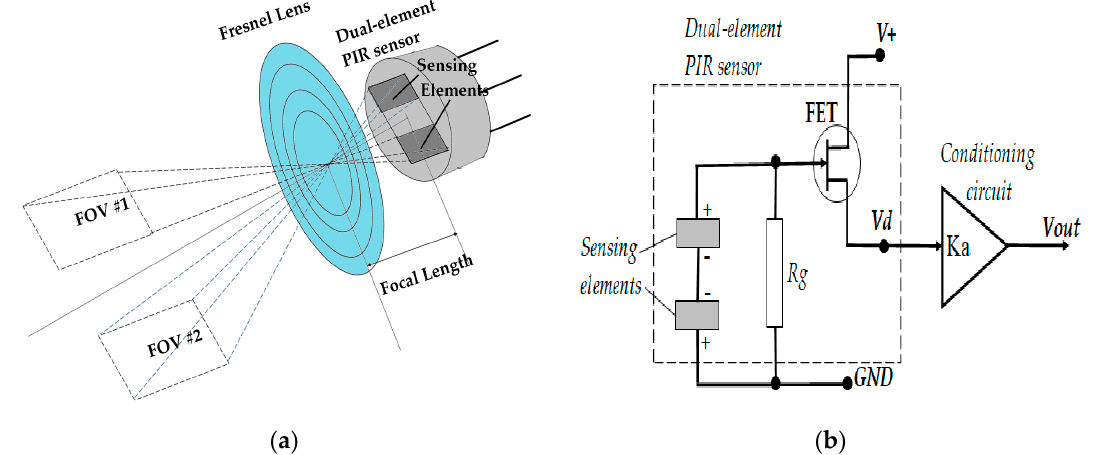
Figure 4 . Illustration of fields of view of PIR sensing elements ( a ), and equivalent circuit of PIR sensor module ( b ).